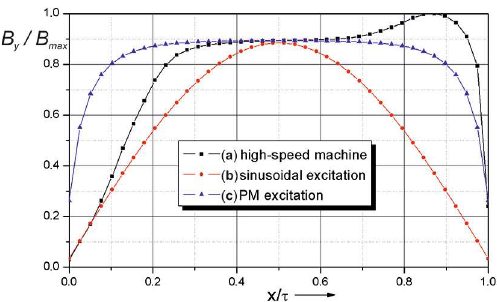
Figure 2. Flux density distributions within the pole pitch for different machine types: ( a ) Salient pole SM or PM-excited SM with a variable air gap (decreasing in the direction of movement); ( b ) Salient pole SM with a synthesized air gap geometry or PM excited SM with a synthesized magnetization; ( c ) Salient pole SM or PM excited SM with large pole coverage.